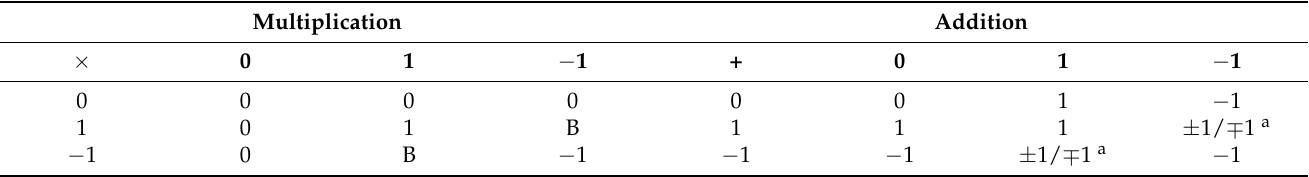
Table 2. Expanded Boolean multiplication and addition for